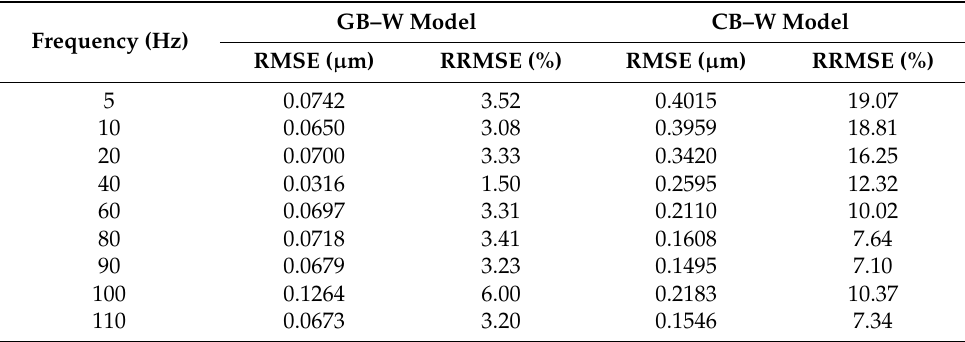
Table 3. Rate-dependent modeling errors of the GB–W model and CB–W model.